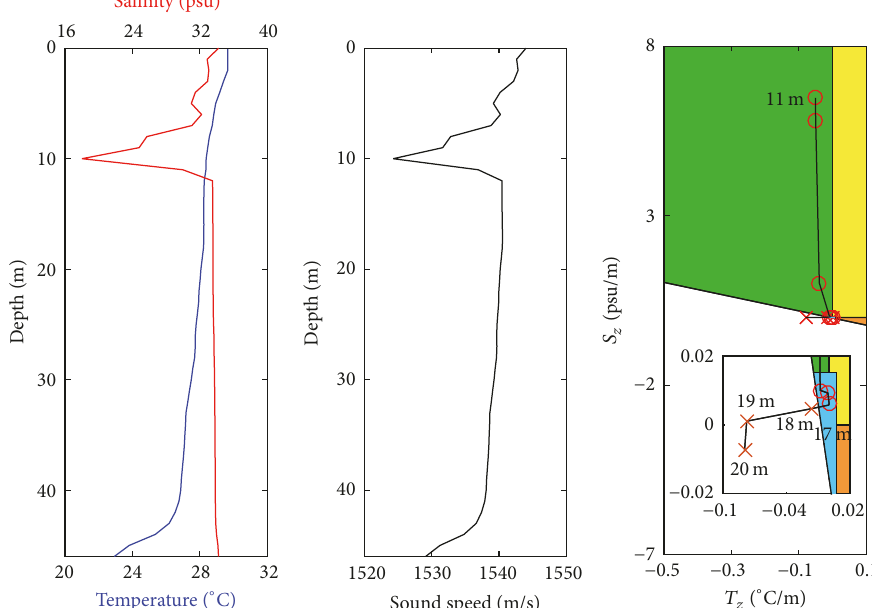
Figure 6: The low-salinity lens case.